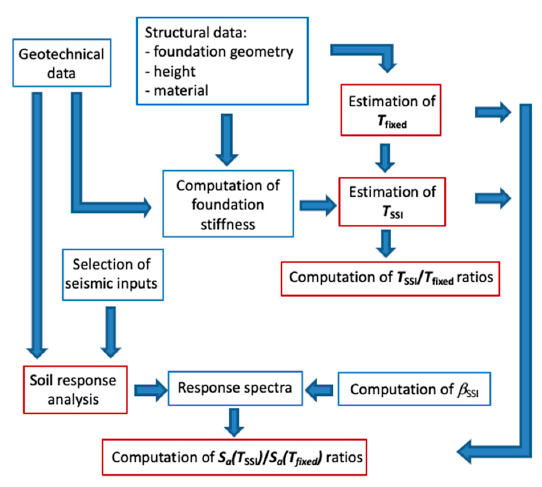
Figure 2. Flow chart of the adopted procedure.